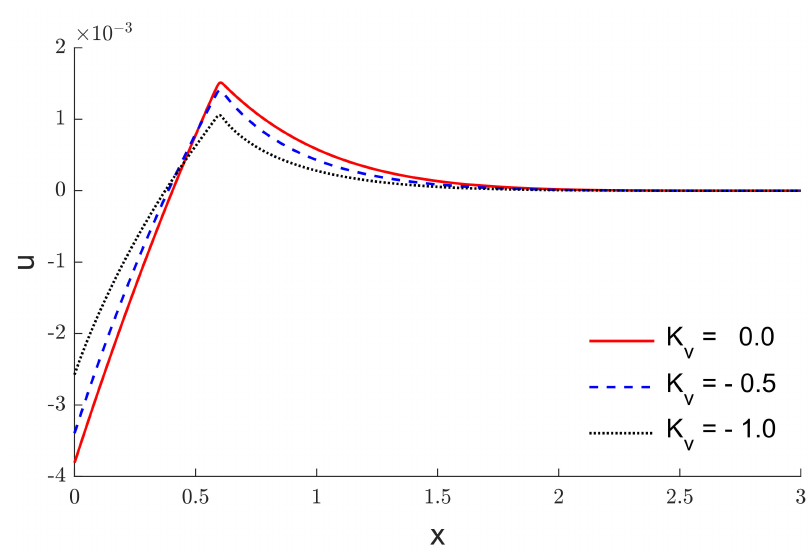
Figure 2. The variation of displacement with respect to the distances with three values of K v